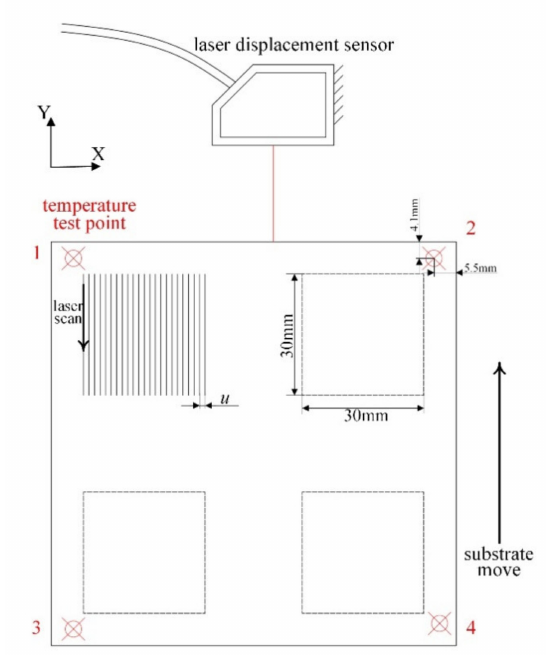
Figure 6. Locations of sensors and Direction of scanning.